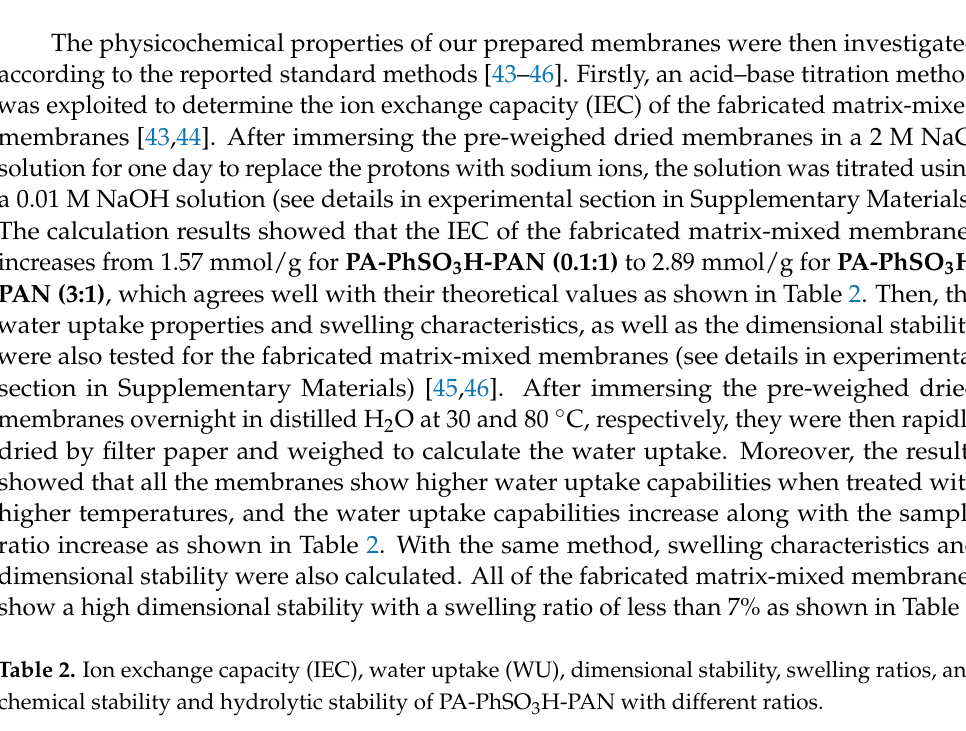
Chemical Hydrolytic Stability Ratio (%)